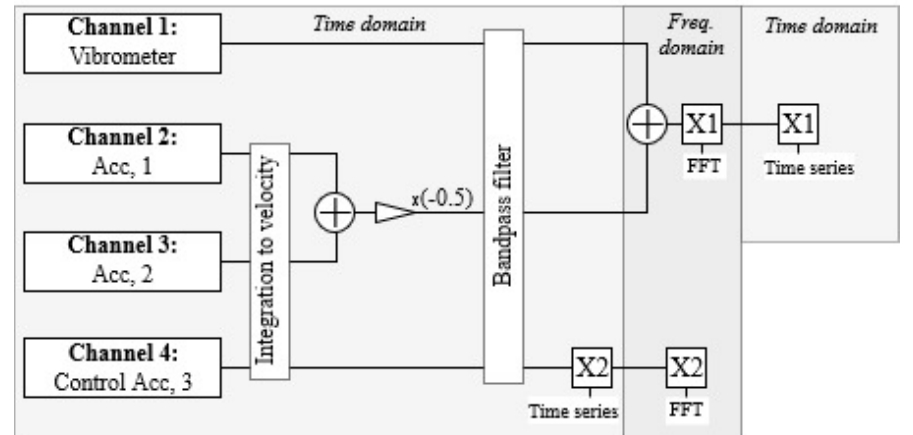
Figure 4. Scheme of mathematical operations on the output of sensor channels. Channel 1 represents the raw vibrometer velocity signal. Channels 2 and 3 represent the integrated velocity signal from accelerometers mounted on the vibrometer, while Channel 4 represents the control measurement of an accelerometer mounted directly on the turbine housing where the vibrometer light illuminates the